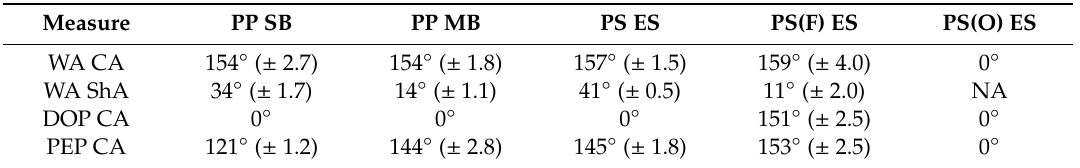
Table 4. Surface wettability of di ff erent